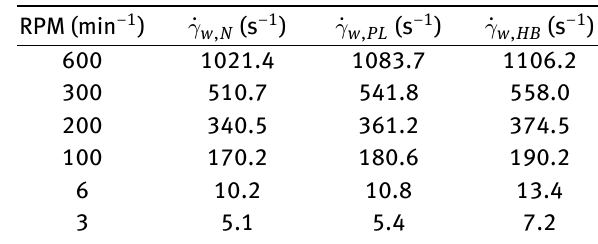
Table 2: Newtonian, power law and Herschel-Bulkley wall shear rates for the WBM measurements in Table 1.